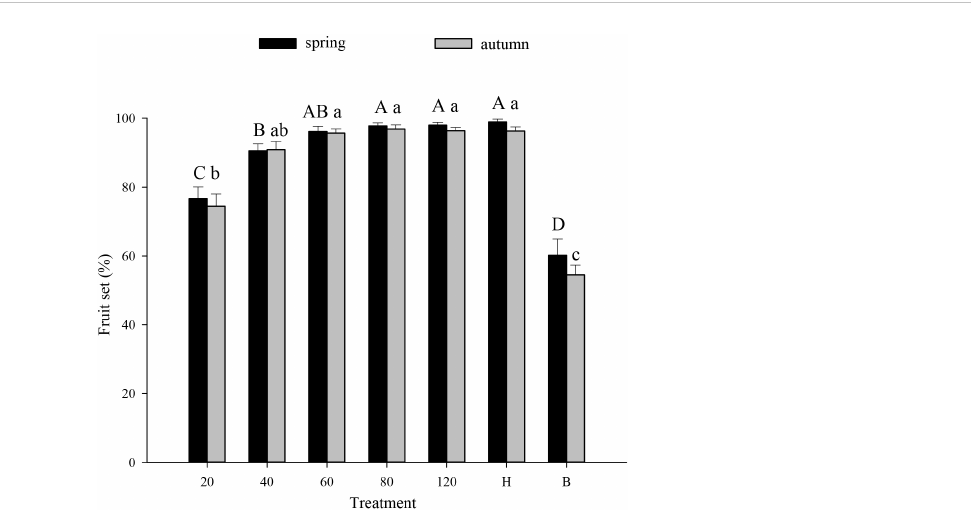
FIGURE 1 Fruit set of tomato (% per plant) under different experimental treatments during spring or autumn 2020-21. Numbers in the X axis refer to the total number of hover fl y adults that were released i.e., 20, 40, 60, 80 or 120; data are also plotted for hormone (H) and bagging (B) treatments. Different uppercase and lowercase letters indicate statistically signi fi cant differences between treatment groups during either season (One-way ANOVA, P <0.05, Tukey ’ s HSD post-hoc